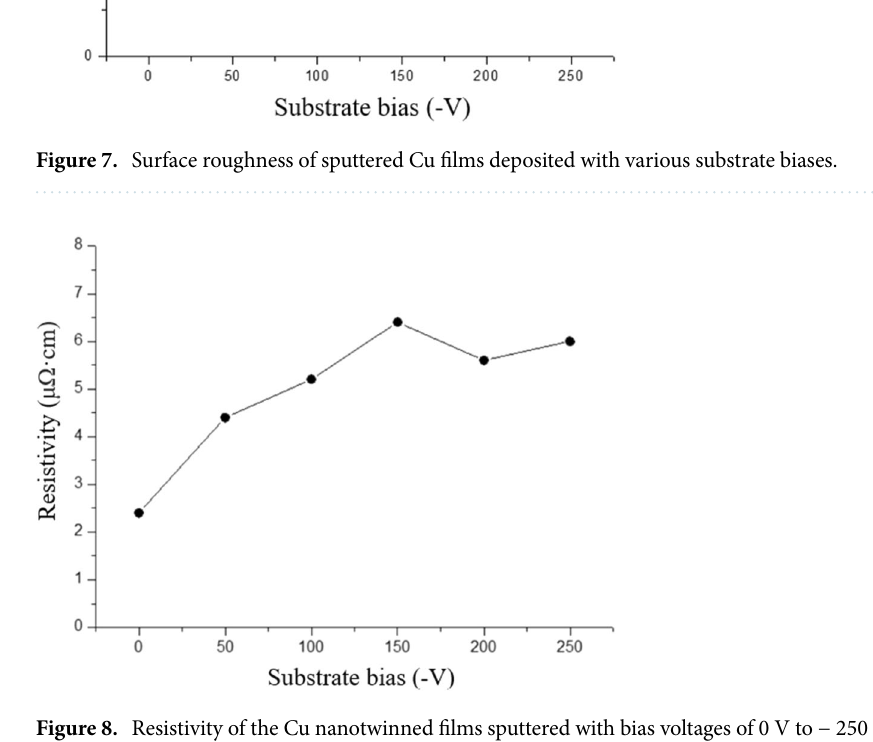
Figure 8. Resistivity of the Cu nanotwinned films sputtered with bias voltages of 0 V to − 250 V.